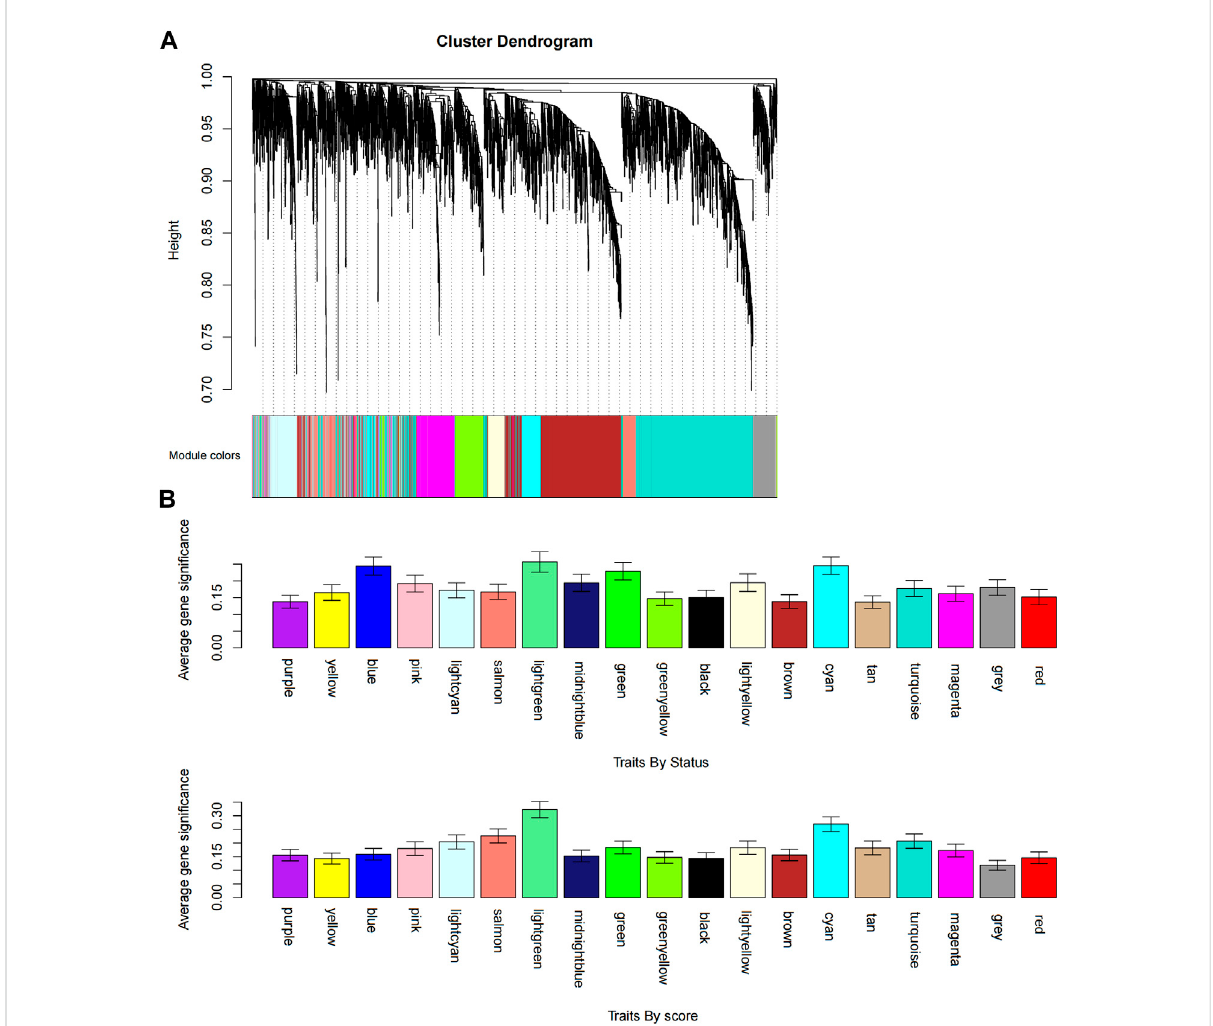
FIGURE 4 Identi fi cation of modules associated with the FOLFIRI response of colon cancer. (A) Dendrogram of all differentially expressed gene clusters based on a dissimilarity measure (1-TOM). (B) Distribution of the average gene signi fi cance and errors in the modules associated with status and scores of colon